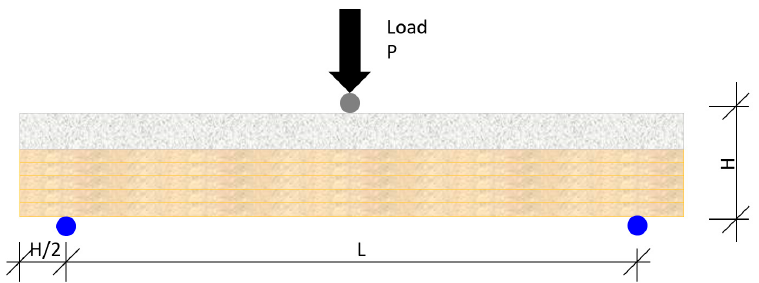
Figure 8. Diagram of the flexural failure test.